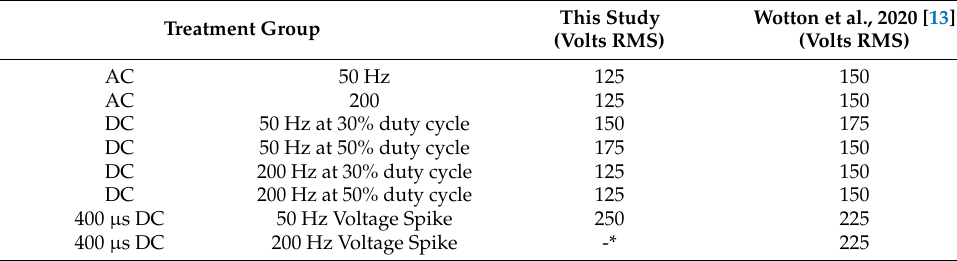
Table 8. Comparison of the recommended voltages for an effective stun.